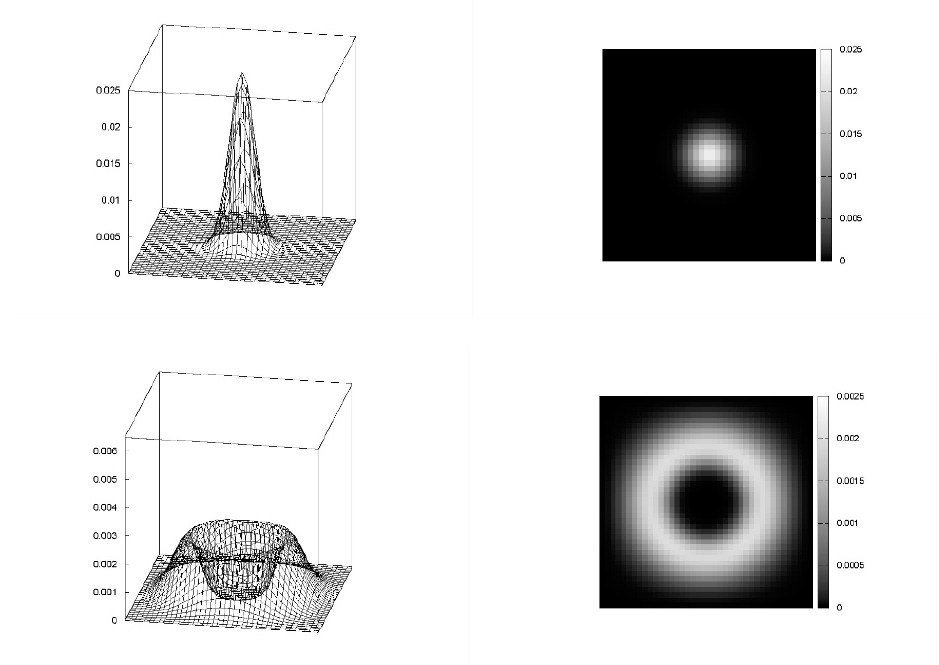
Figure 4. The interaction strength is κ = 10